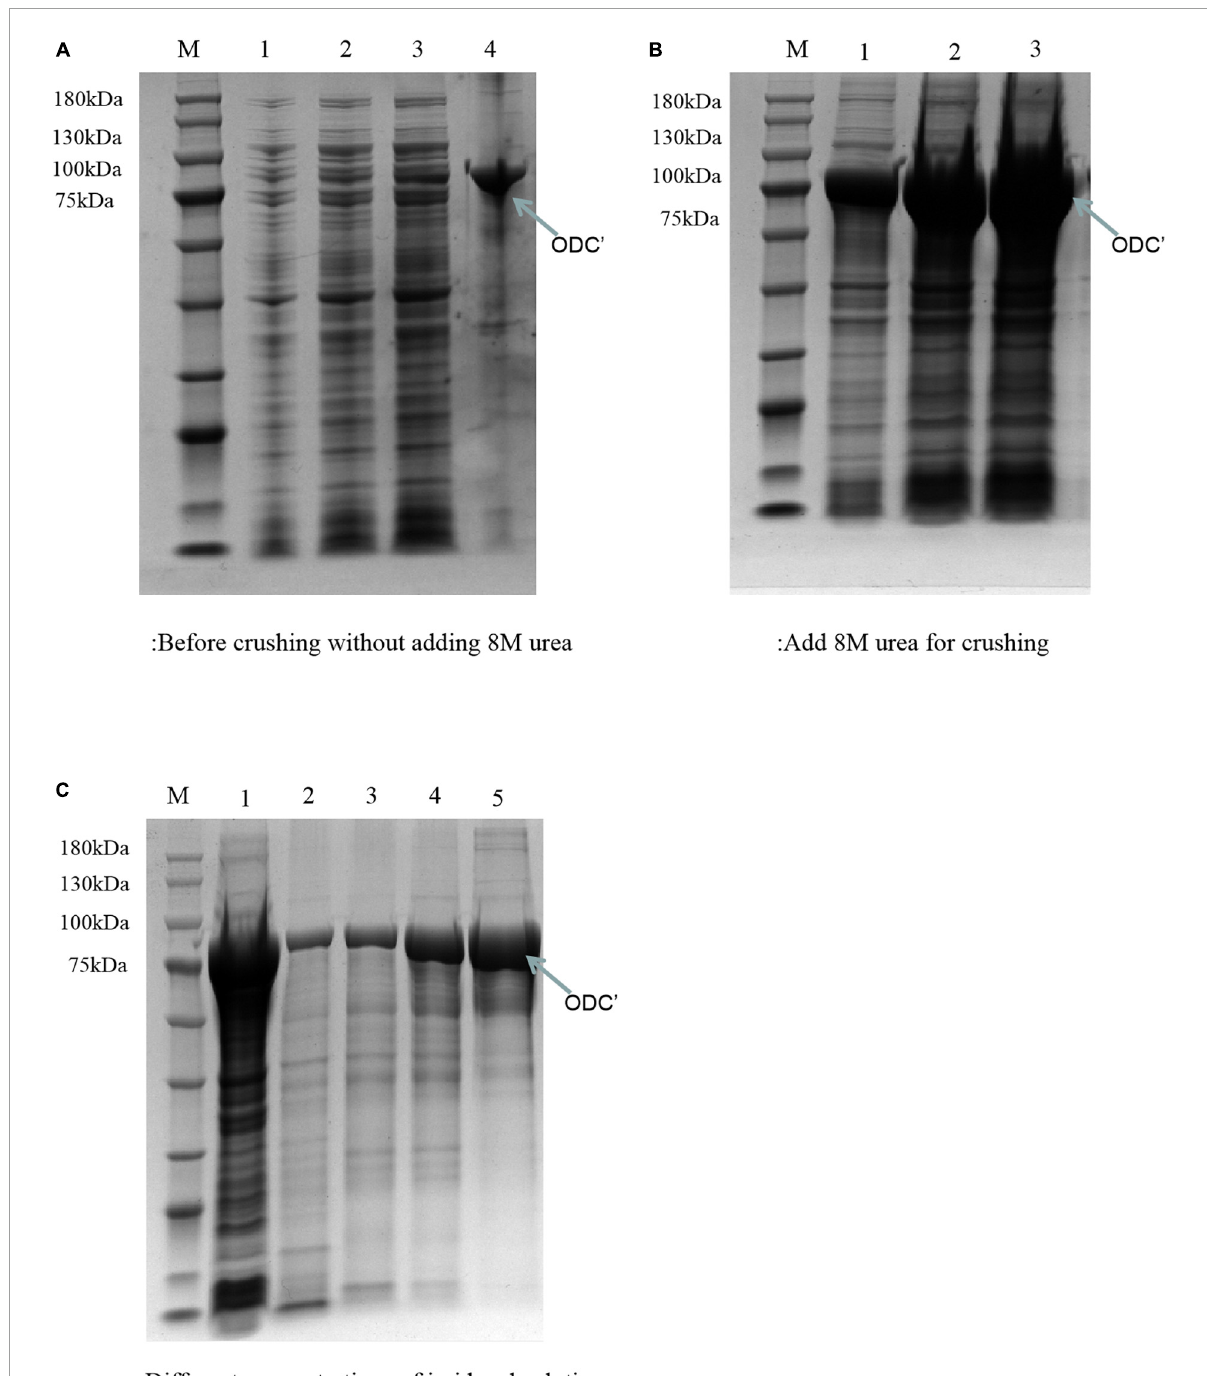
FIGURE5 SDS-PAGE analysis of ODC under the express condition of 1 M IPTG at 25 ◦ C for 12 h. M represented the protein marker (180 kDa). (A) Represented the components before adding 8 M urea. Lanes 1–3 represented the supernatant of crushed cells centrifuge precipitate with different volumes (1, 3, and 5 µ L), respectively. Lane 4 represented the precipitate of crushed cells. (B) Represented the components after adding 8 M urea. Lanes 1–3 represented the precipitated solutions with different volumes (1 µ L, 3 µ L, 5 µ L), respectively. (C) SDS-PAGE verification of the different concentrations of imidazole eluents. Lane 1 represented the supernatant after breaking by a low-temperature high-pressure cell crusher. Lanes 2–5 represented the eluents of different concentrations of imidazole (20, 50, 100, and 200 mM),